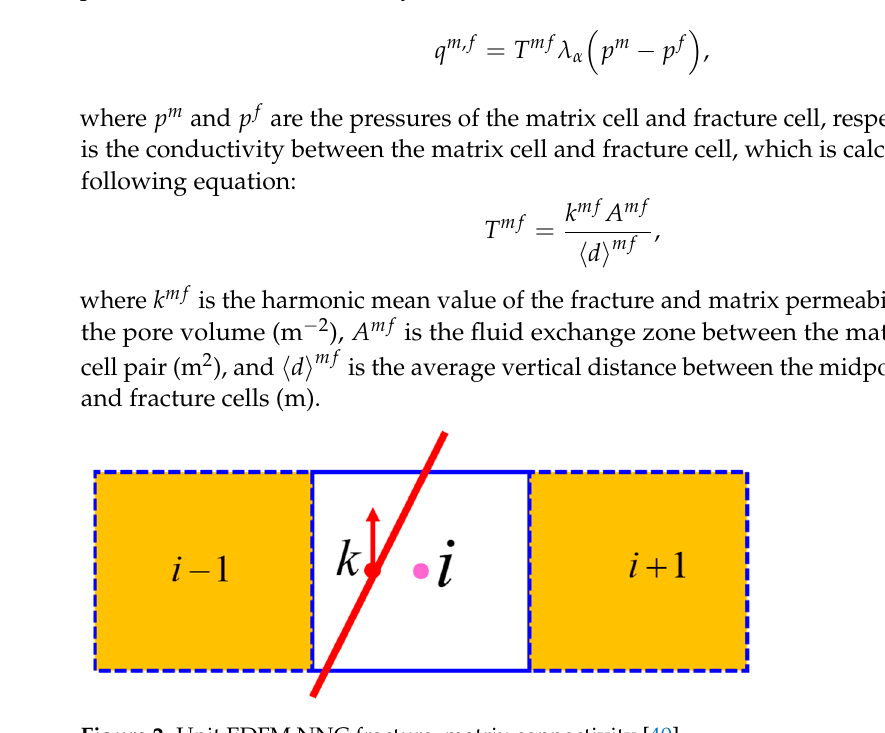
Figure 2. Unit EDFM NNC fracture–matrix connectivity [40].